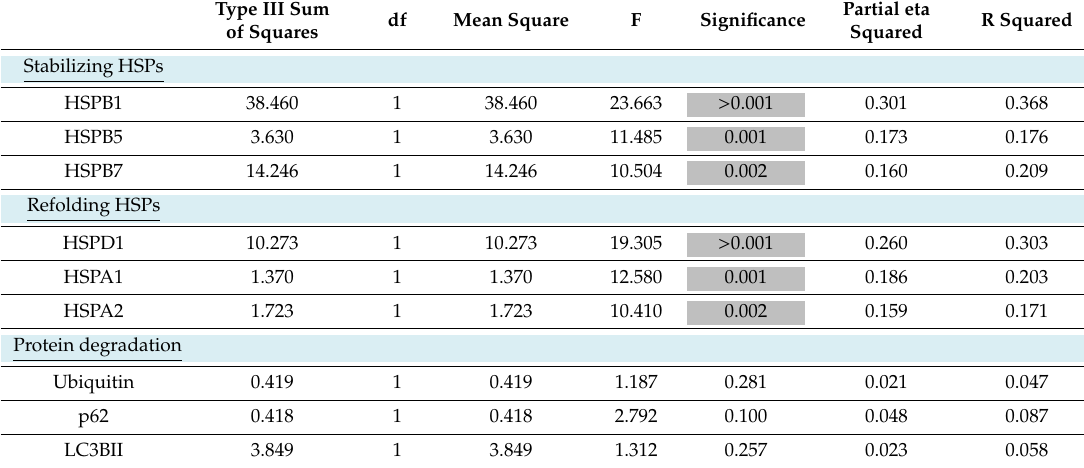
Table 8. Tests for between-subjects: α -tubulin as an e ff ect and correction for di ff erences in sex and age at